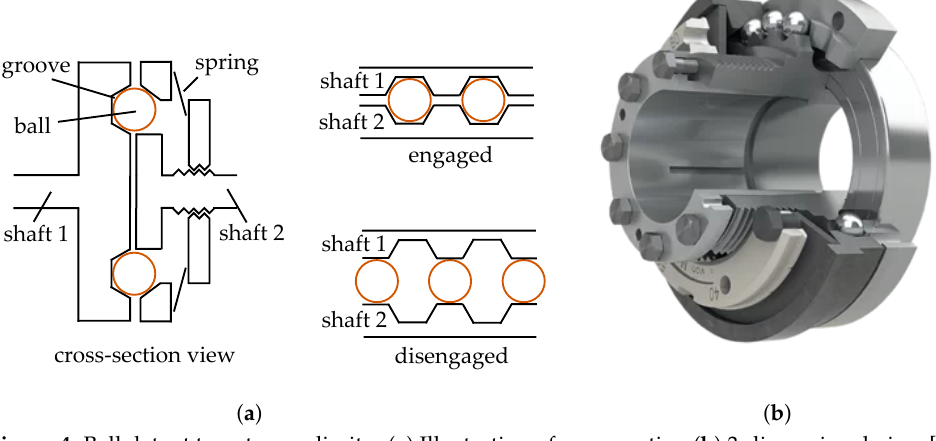
Figure 4. Ball detent type torque limiter ( a ) Illustration of cross-section ( b ) 3-dimensional view [26]. Reproduced with permission from Mayr, The Backlash-Free, Load Disconnecting Safety